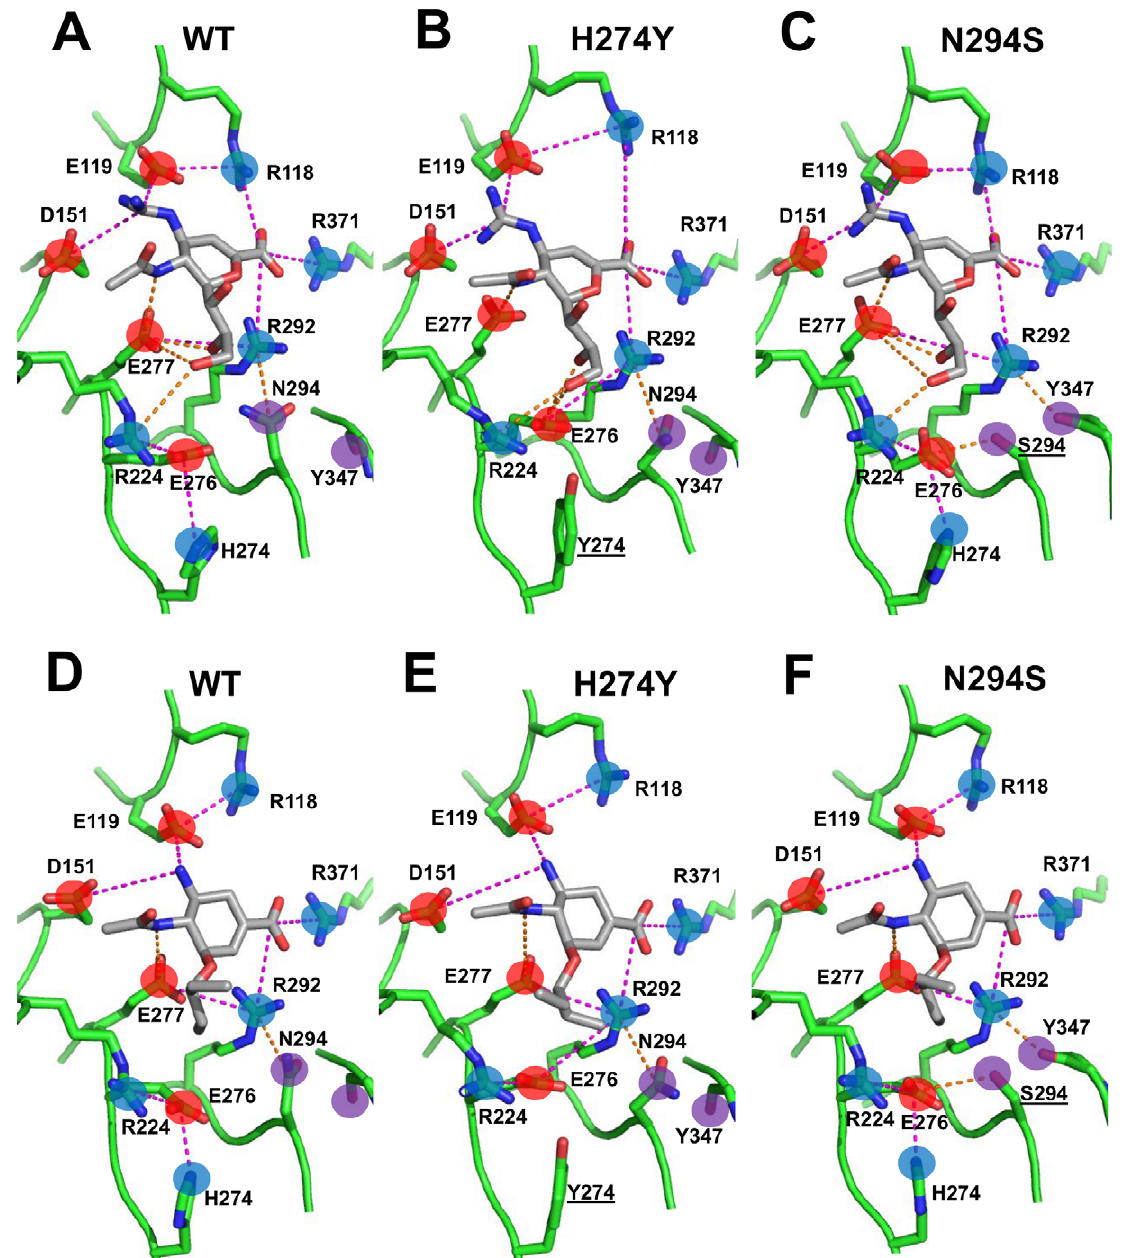
Figure 2. Representative structures for zanamivir (A, B and C) and oseltamivir (D, E and F) bound to WT and mutant NAs from the SRSM/HREX simulations. Salt-bridges and hydrogen bonds are depicted as magenta and orange dashed lines, respectively. Positively charged, negatively charged, and uncharged polar groups are noted as blue, red, and purple circles, respectively, and residues of interest are labeled. Mutated residues are